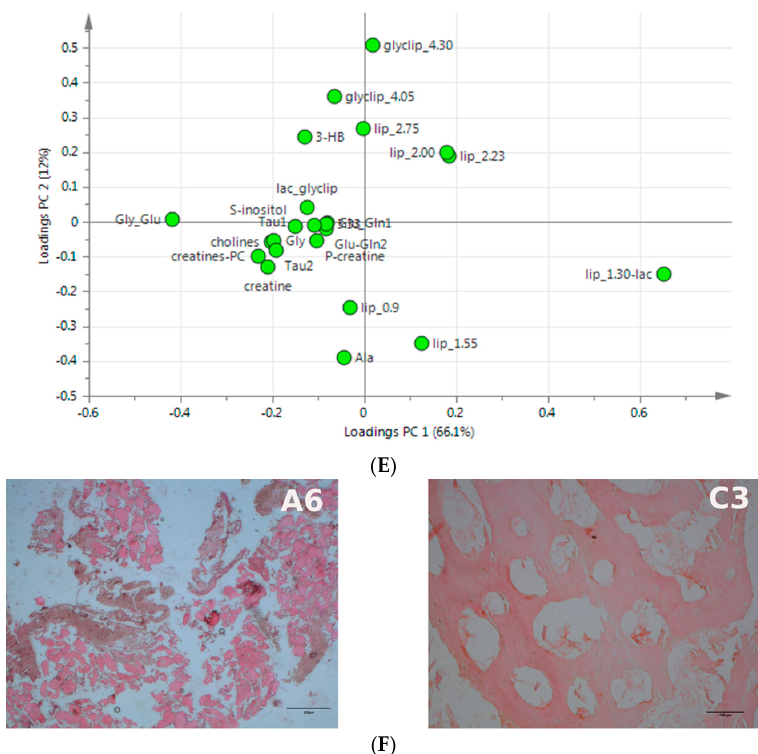
Figure 3. Multivariate analysis of NMR spectra and histological features. NOESY spectra acquired from samples of different origins were statistically analyzed after binning. Classification of specimens was based on their morphological appearance at the time of sampling. ( A ) Score plot showing the first two principal components, with black, red, and green dots, respectively corresponding to muscle (group A), oily tumor (group B), and calcified tumor samples (group C). The quality control sample A4/B4, prepared by mixing muscle and tumor specimens, is colored in blue. The oval represents the 95% confidence interval of the analysis; ( B ) Loadings plot of the analysis performed in ( A ). Profiled bucket metabolites and their ppm values are shown for those regions displaying loadings responsible for separation along the first two principal components (PC1, PC2); ( C ) Histological staining of mixed control samples (A4/B4) and of outliers (B8, C8) with hematoxylin and eosin (5X, Axioplan Leica). Upon staining of 5 μ m sections, nuclei appear stained by hematoxylin (violet/blue), muscle fibers by eosin (red), loose connective tissues are weakly stained, and fat remains white. Scale bar = 100 µ m; ( D ) PCA score plot comparing muscle samples (group A, in black) with tumor samples (groups B and C, in red) after exclusion of the two outliers (B8, C8) and the mixed control sample (A4/B4); ( E ) Loadings plot of the analysis performed in ( D ); ( F ) Histological staining of misclassified samples (A6, C3). Sample A6 shows tumor cells between muscle fibers. Sample C3 shows more organized calcified tissue. Scale bar = 100 μ m.